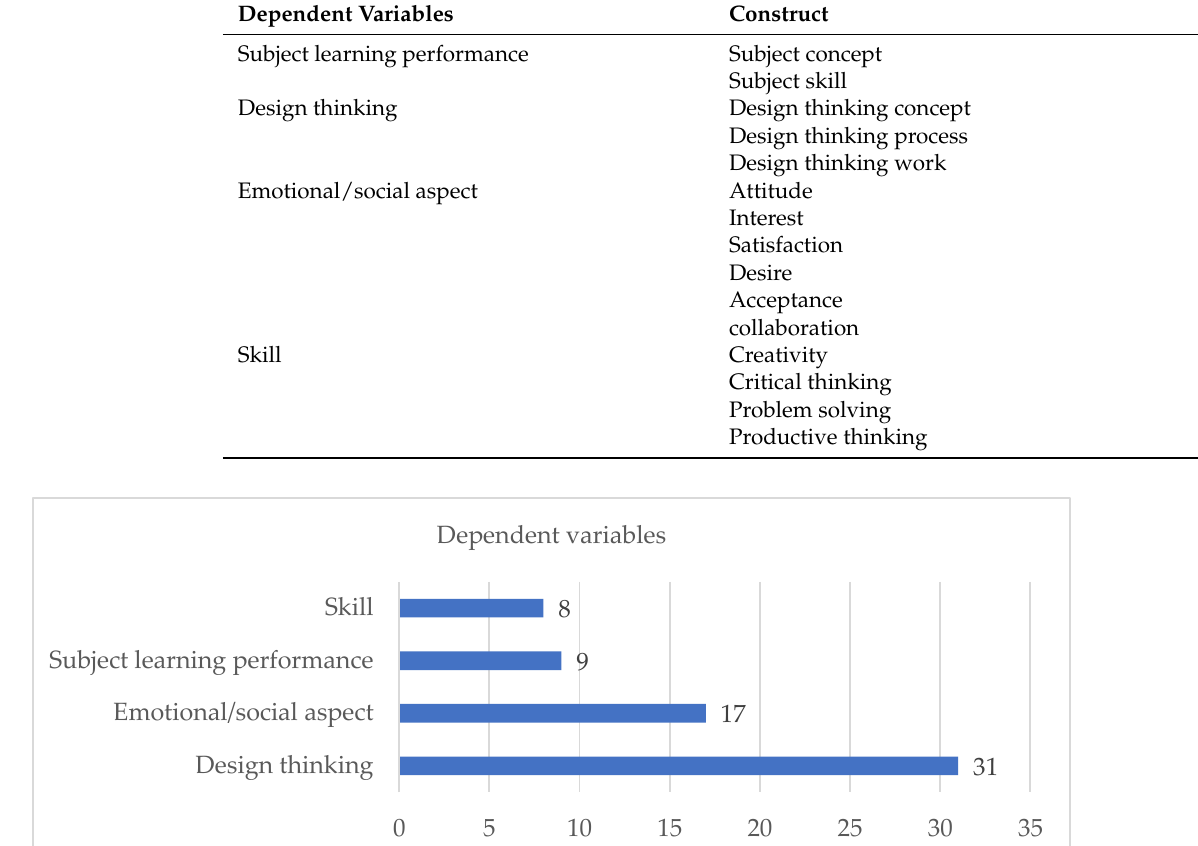
Table 3. Dependent variables evaluated in the empirical studies.